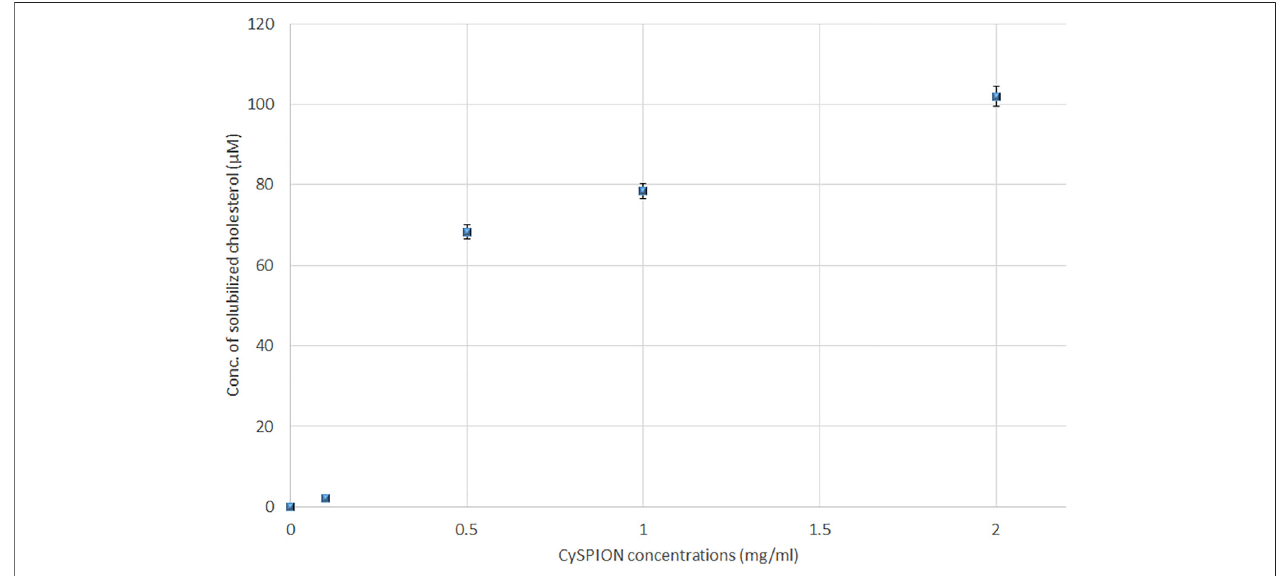
FIGURE 4 | Solubilized cholesterol (in µM) due to the formation of inclusion complex with β -CD from hydrolysis of CySPION in Acetate buffer.